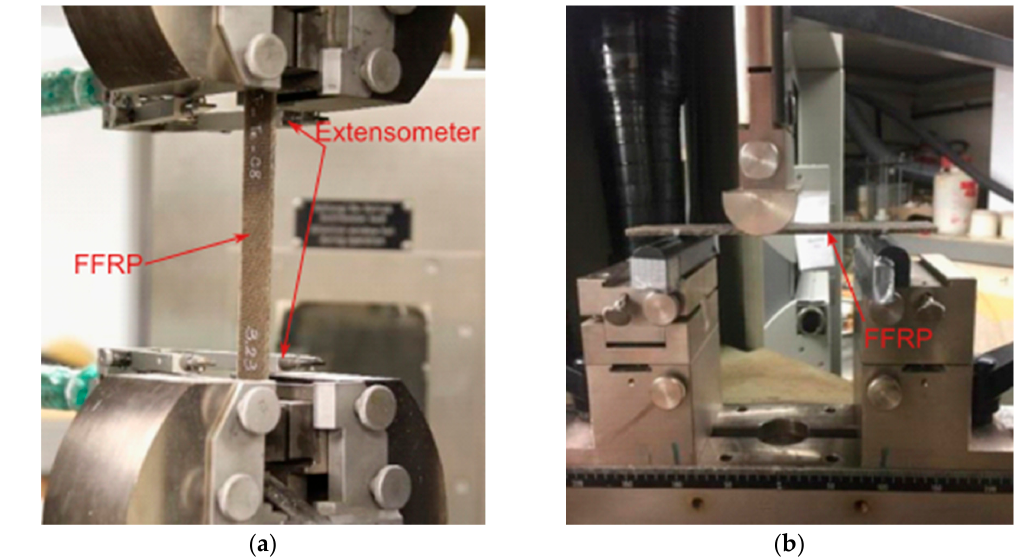
Figure 2. ( a ) Flat coupon tensile test and ( b ) bending test for fiber reinforced polymer (FRP) laminates.